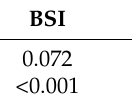
Treatment Groups